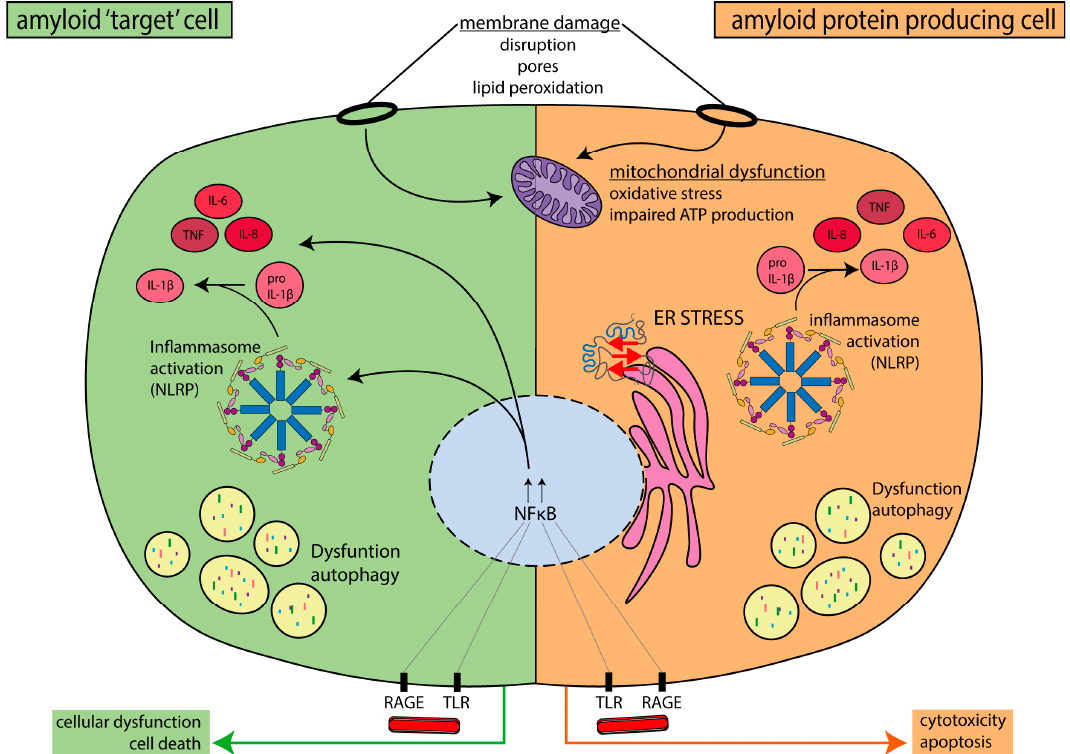
Figure 4. Overview of the cell biological mechanisms that have been implicated in amyloid-protein- induced cellular damage and apoptosis and peripheral neuropathy, both in cells producing an amyloid protein and in other cells affected by amyloid or amyloid protein aggregates. Such “amyloid target cells” include cell types that degrade amyloid and protein aggregates after phagocytosis (macrophages and microglia), as well as Schwann cells (involved in nerve function and integrity) and endothelial cells (involved in microangiopathy).